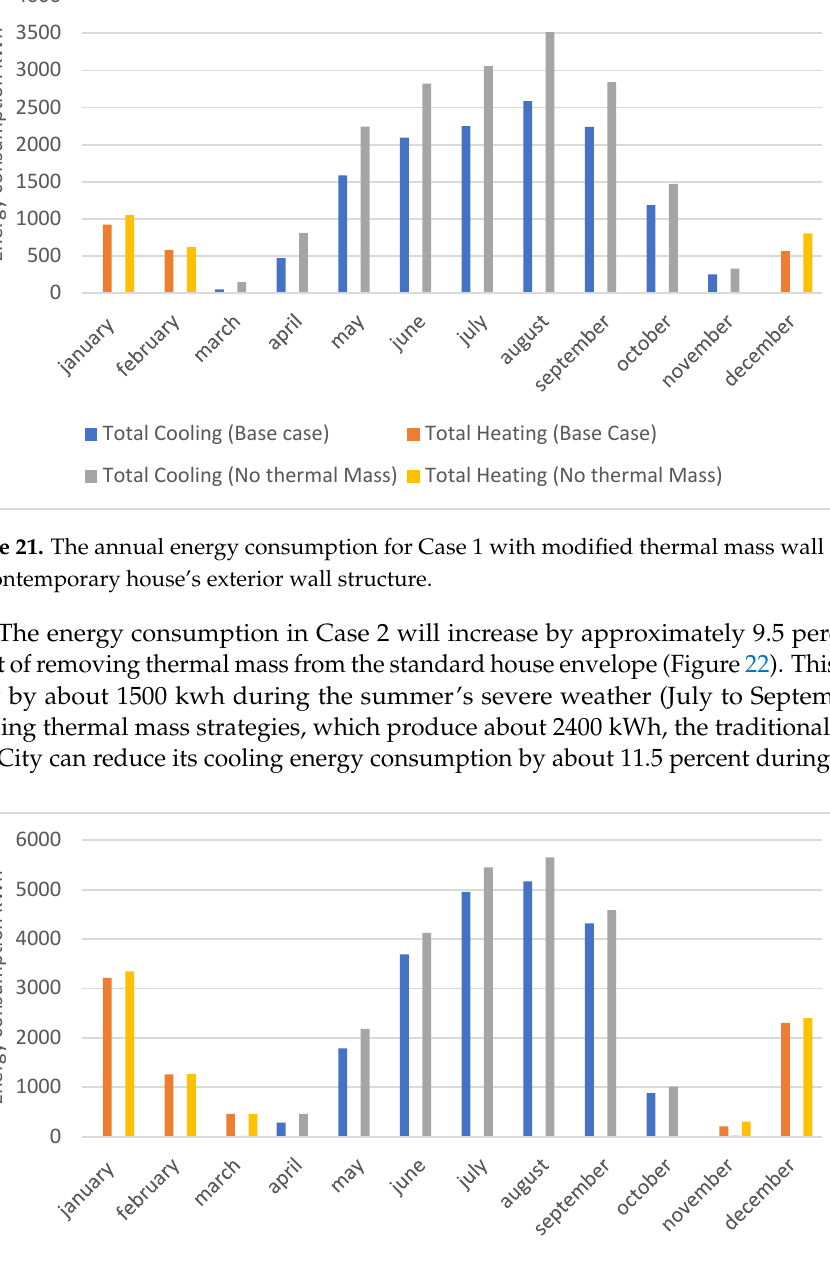
22 of 25 Figure 20. Annual energy consumption for Case 2 with and without shading device. 4.4. Investigation into the Impact of Thermal Mass on Vernacular Architecture This phase examined the energy demand for traditional houses in Saudi Arabia that use thermal mass walls. According to the simulation results, thermal mass walls play an imperative role in decreasing the total amount of energy consumed by traditional houses in Najd. The researchers simulated thermal mass walls and modified them to resemble the exterior wall structure of a contemporary house. For traditional houses in Riyadh